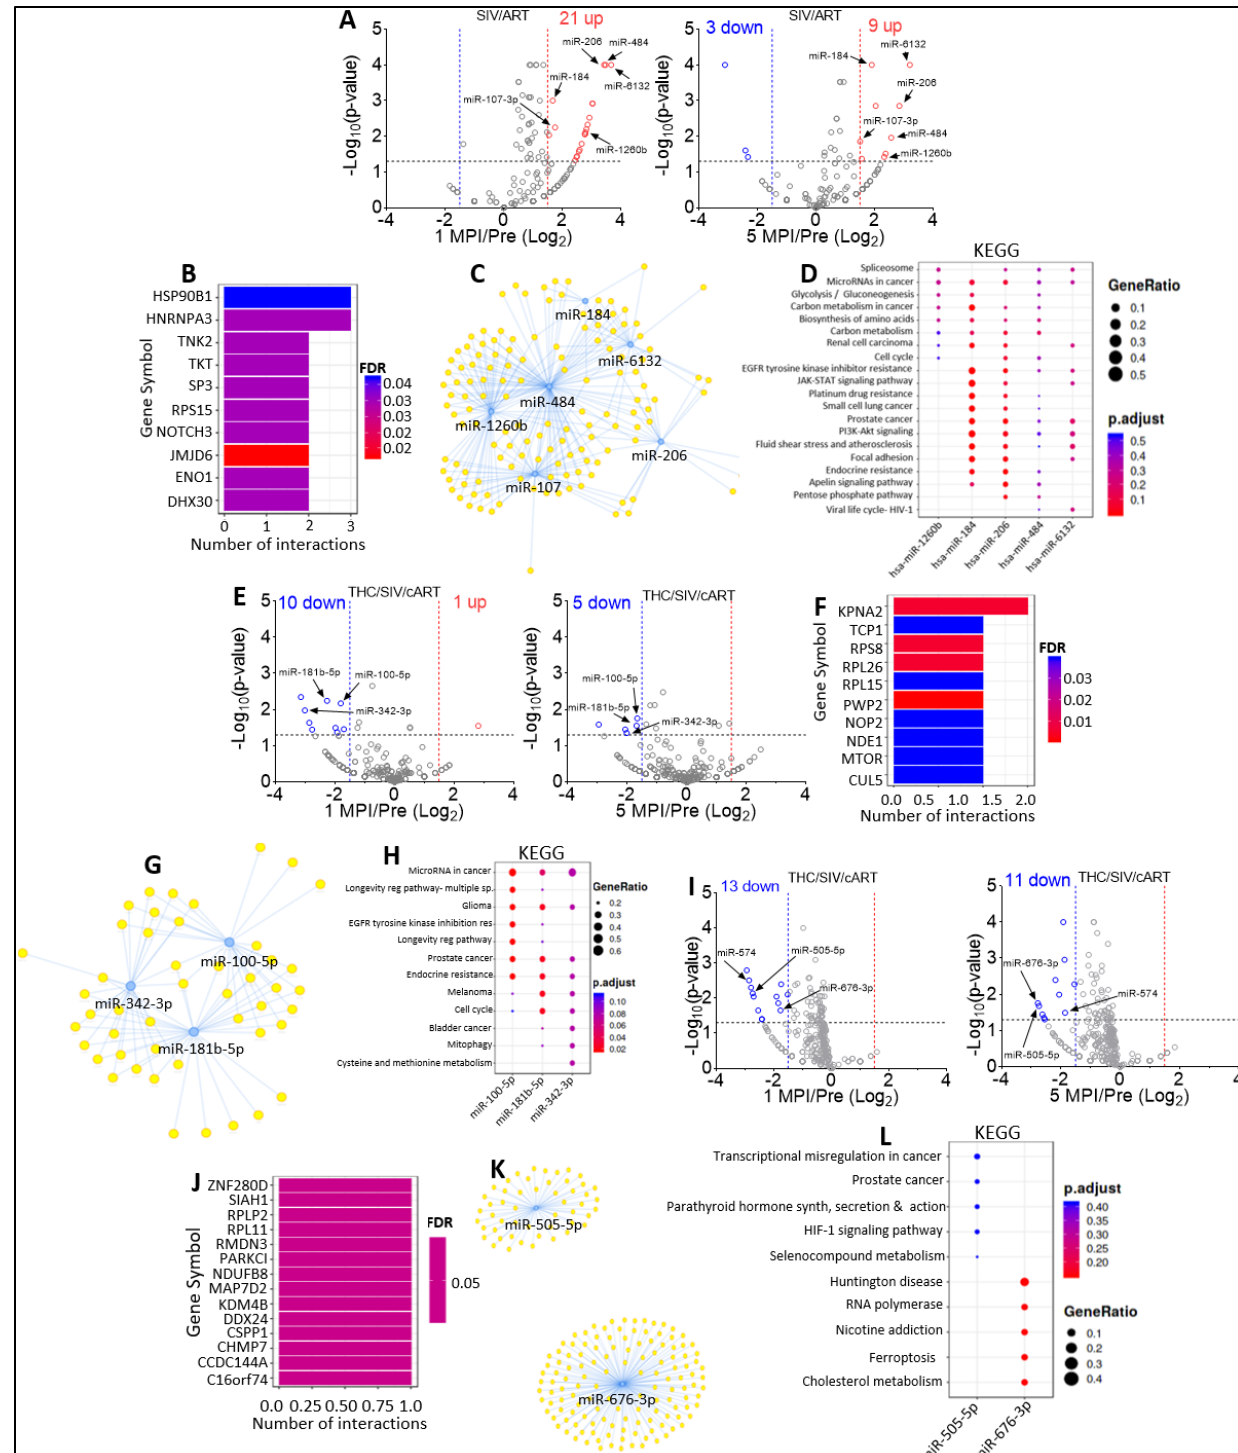
Figure 7. Identification of differentially and longitudinally altered EV − and EC − associated miRNAs of SIV-infected cART and/or THC treated RMs: ( A ) Volcano plot showing down-(blue) regulated and up-(red) regulated miRNAs in SIV/ART EVs at 1 MPI (left) and at 5 MPI (right). Black arrows indicate longitudinally upregulated miRNAs. ( B ) miRNA-target enrichment analysis showing top target genes by number of interactions for the longitudinally upregulated EV-associated miRNAs in panel A. ( C ) Visualization of miRNA-target interaction network for the